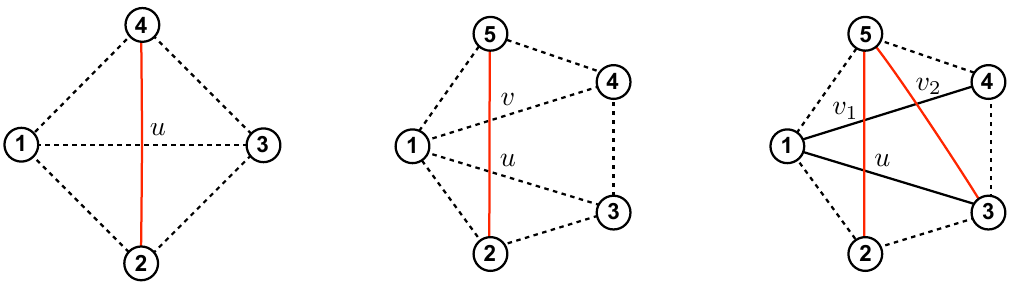
Figure 11 . Left and middle panels: free propagator cut once and twice. We cut the interior of the polygon into two and three hexagons, respectively. The dashed middle lines denote bridges of length zero. Outer bridges / boundaries play no role here. For de(cid:12)niteness, one could give them arbitrarily large length to emphasize that nothing can leak out of the polygons. On the right panel, we give an example of a loop integral that could be hexagonalised by adding bridge lengths | for the horizontal propagators | and further magnons for the vertical